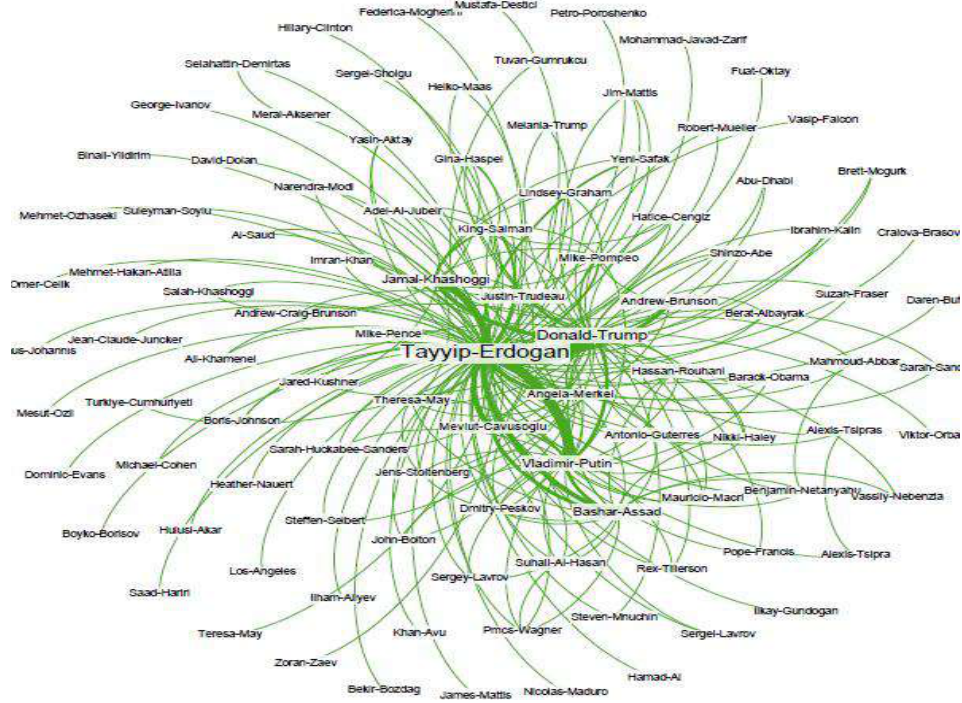
Figure 5: 2018 Network (Source: Authors ‟ depiction)